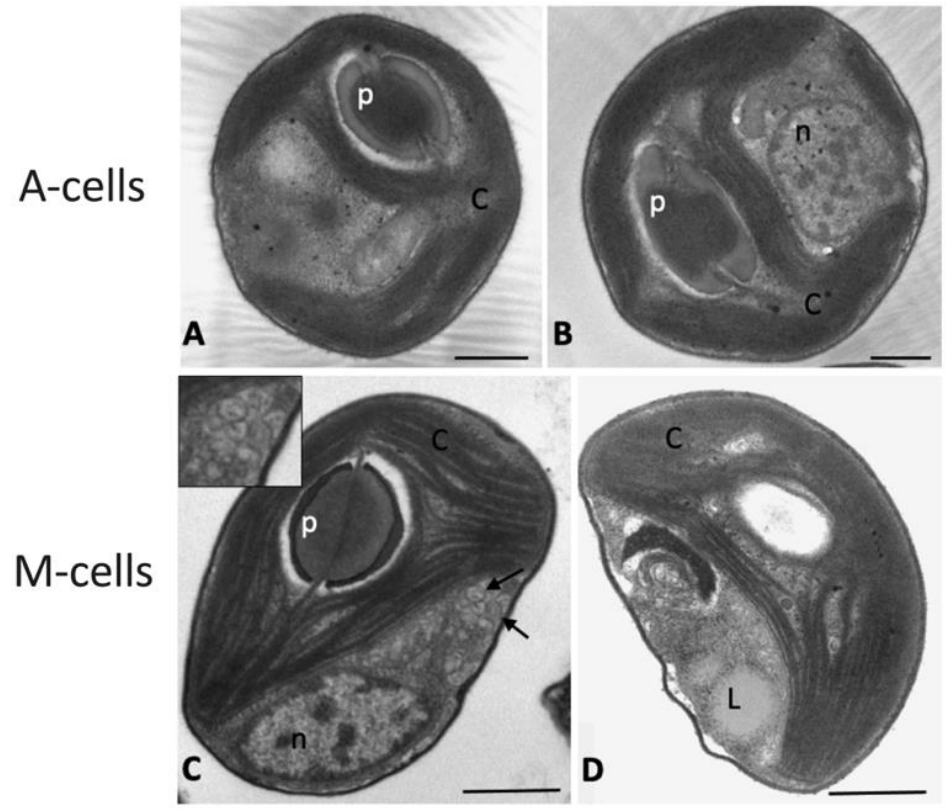
Figure 4. Transmission electron microscopy images of N. oleoabundans cells belonging to autotrophic ( A , B ) and mixotrophic ( C , D ) cultures at 28 and 12 d of cultivation, respectively. A-cells refer to algae in autotrophic cultures, while M-cells refer to algae in mixotrophic ones. C, chloroplast; p, pyrenoid; n, nucleus; L, lipid globule; arrows, cytoplasmic vesicles. In ( C ), insert shows a detail of vesicles at larger magnification. Bars: 0.5 μm.